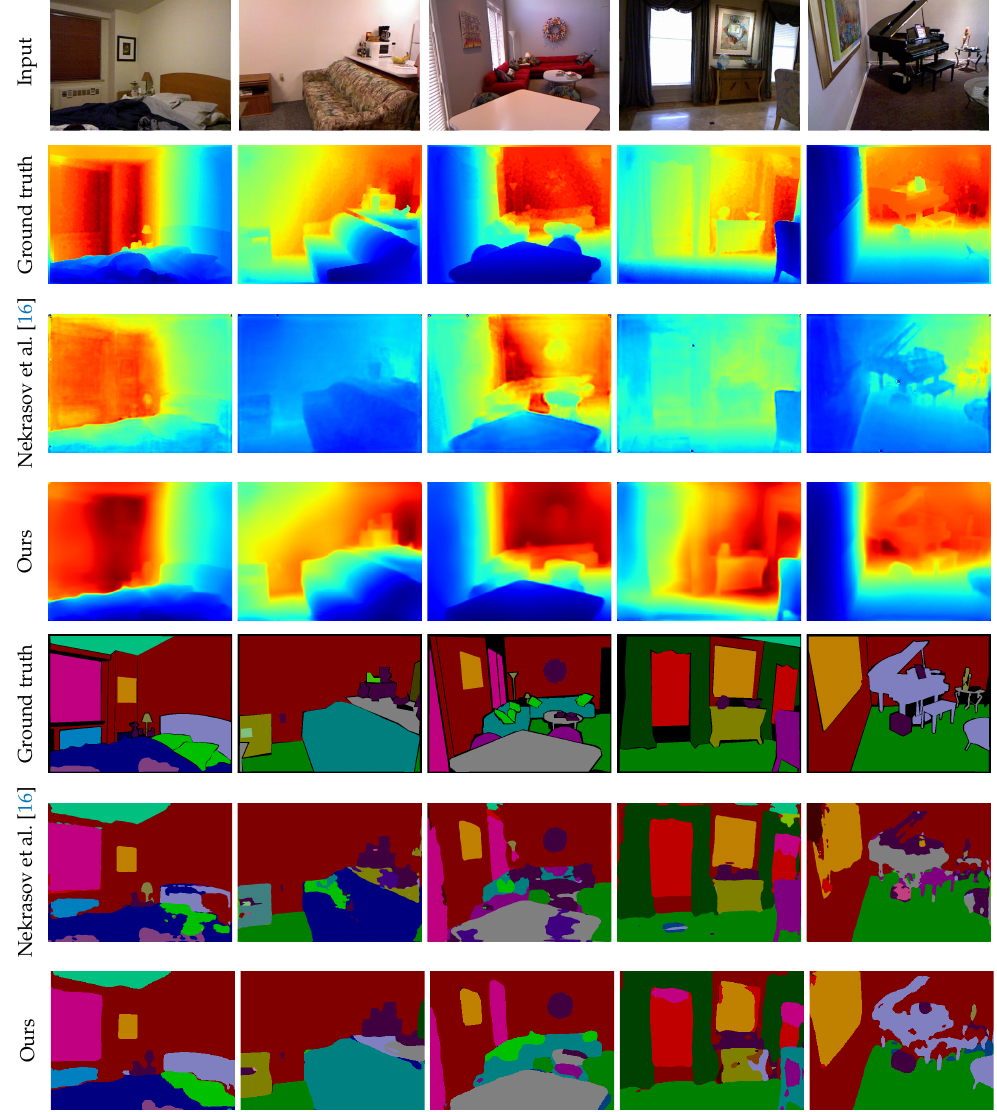
Figure 3. Qualitative comparison with recent joint learning approach on the NYU Depth v2 dataset. From the top to the bottom, input images, ground truth depth maps, depth results of Nekrasov et al. [16] and our proposed approach, ground truth semantic labels, and segmentation results of Nekrasov et al. [16] and our approach,